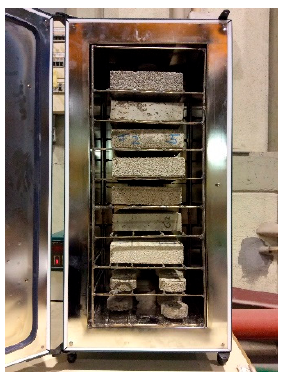
Figure 1. Thermal chamber before the tests.